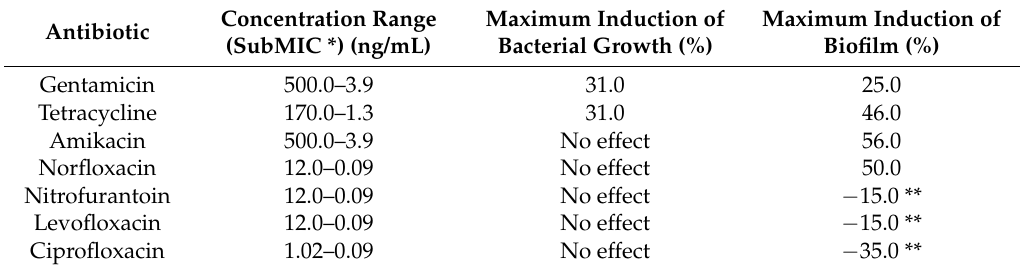
Table 2. Effect of some antibiotics on bacterial growth and biofilm formation.